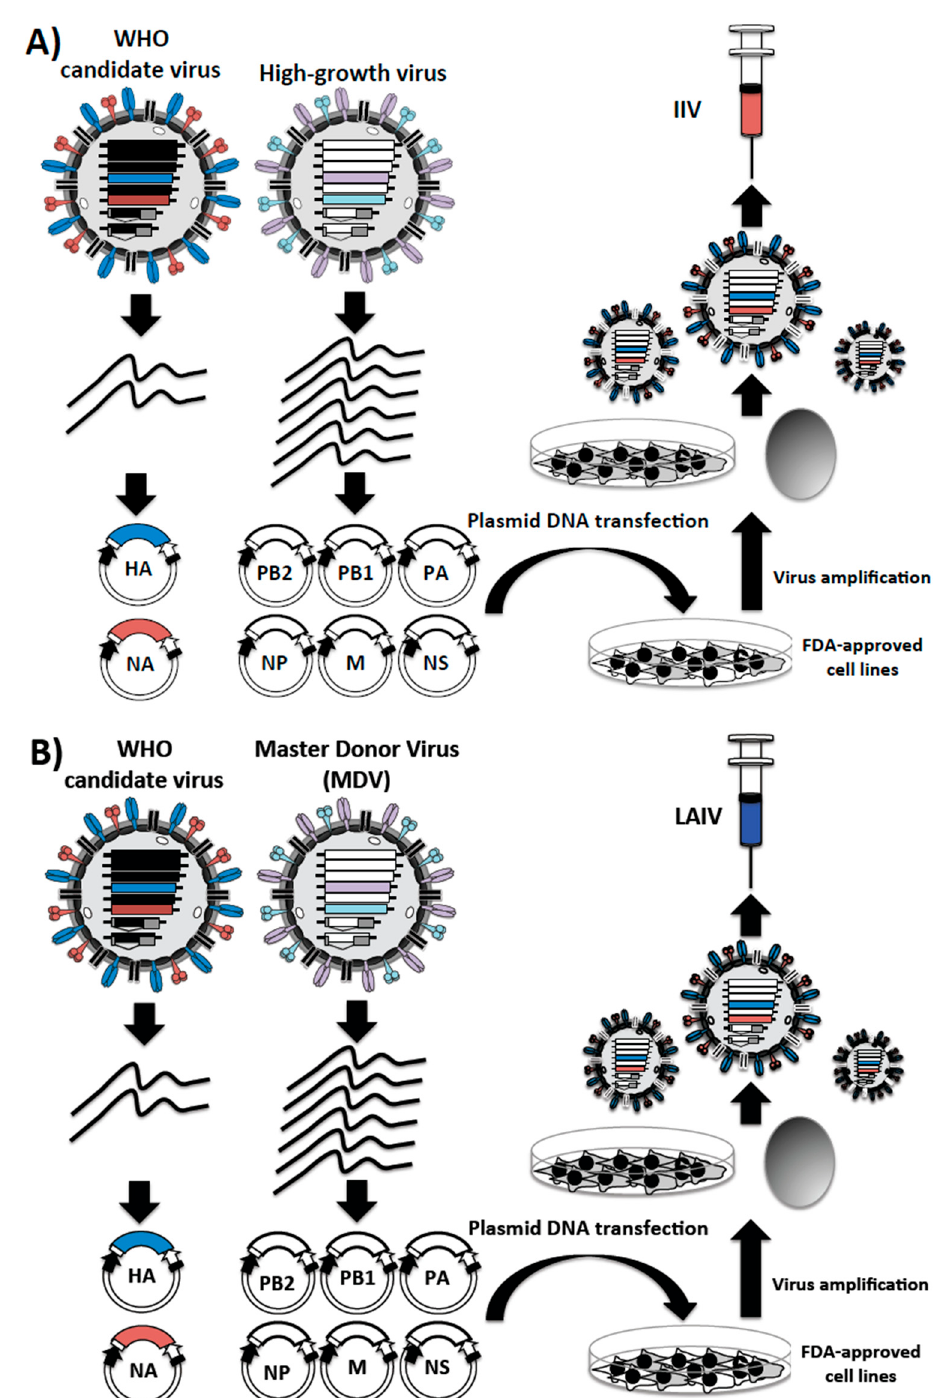
Figure 4. Reverse genetics approaches to generate influenza vaccines: For the development of reverse genetics, influenza vRNAs are cloned into the eight bi-directional plasmids. Transfection of the eight ambisense plasmids into permissible FDA-approved for vaccine production cell lines leads to the rescue of the recombinant influenza viruses containing the six internal genome segments from the high-growth virus ( A ) or from the MDV ( B ) and two genome segments (the HA and NA encoding segments) from WHO candidate strain for their use as IIV ( A ) or LAIV ( B ), respectively. Because the viruses are derived entirely from DNA, no selection system is needed to isolate the desired reassortant. The rescued viruses can be amplified and used as seed viruses for vaccine production.